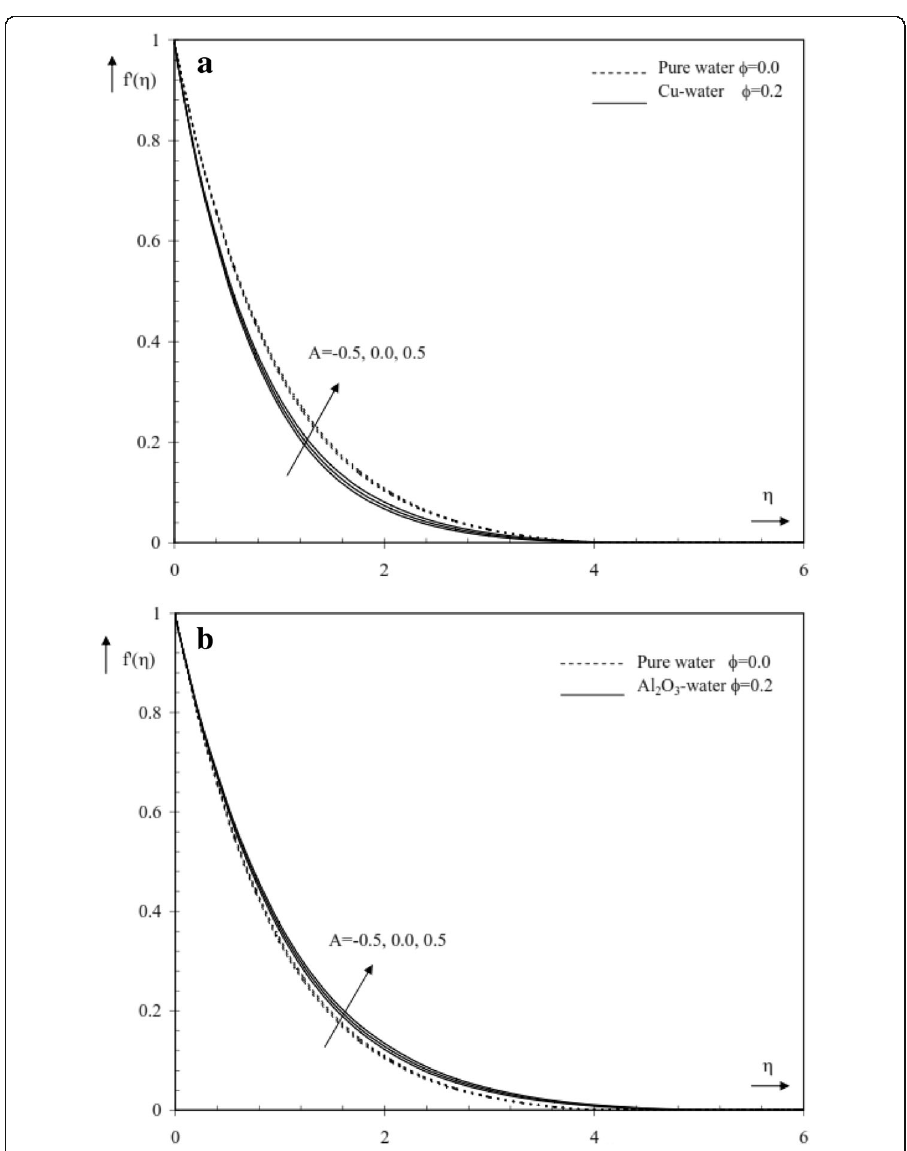
Fig. 9 Effects of ϕ and A on velocity distribution f ′ ( η ) for S = M = f w = 0.1 and B = λ = 0.5 for a Cu-water and b Al 2 O 3 From Table 3, as compared to the case of no heat source/sink ( A = B = 0), the skin friction coefficient and the local Nusselt number are augmented due to heat sink ( A < 0 and B < 0) whereas the opposite results hold with heat source ( A > 0 and B > 0), for all values of nanoparticle volume fraction. On the other hand, the skin friction coefficient increases for Ag-water and Cu-water by increasing nanoparticle volume fraction φ , whereas the opposite results occur for Al O -water and TiO -water. Additionally, the 2 3 2 local Nusselt number decreases by increasing nanoparticle volume fraction φ for all values of heat source/sink A and B . From Table 4, it is observed that the skin friction coefficient and the local Nusselt number increases by increasing f (for pure fluid ( φ = w 0) and four different types of nanofluids). These results are similar to that reported by Das [44]. On the other hand, the skin friction coefficient increases by increasing